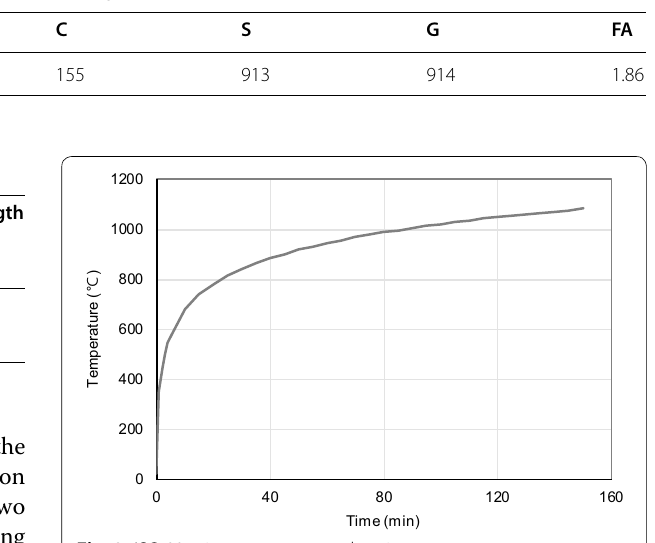
Fig. 2 ISO 834 time–temperature heating